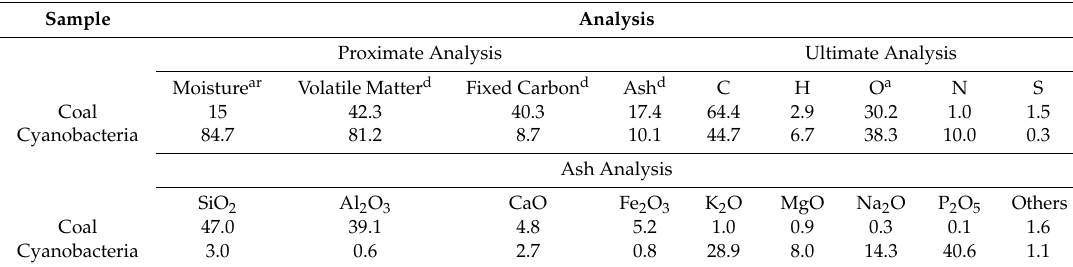
Table 1. Main characteristics of cyanobacteria and lignite coal